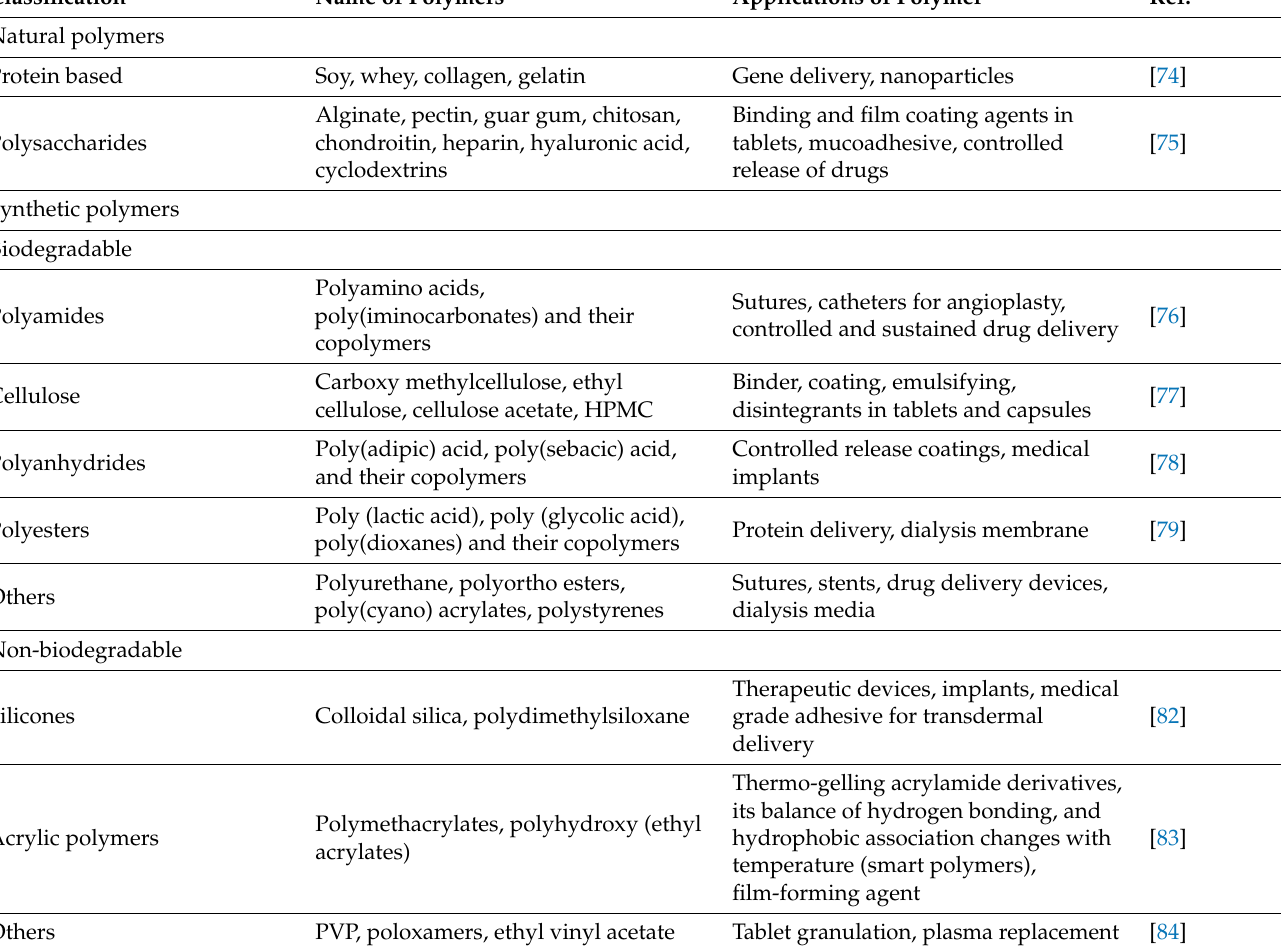
Table 1. Applications of nanopolymers in pharmaceutical and clinical